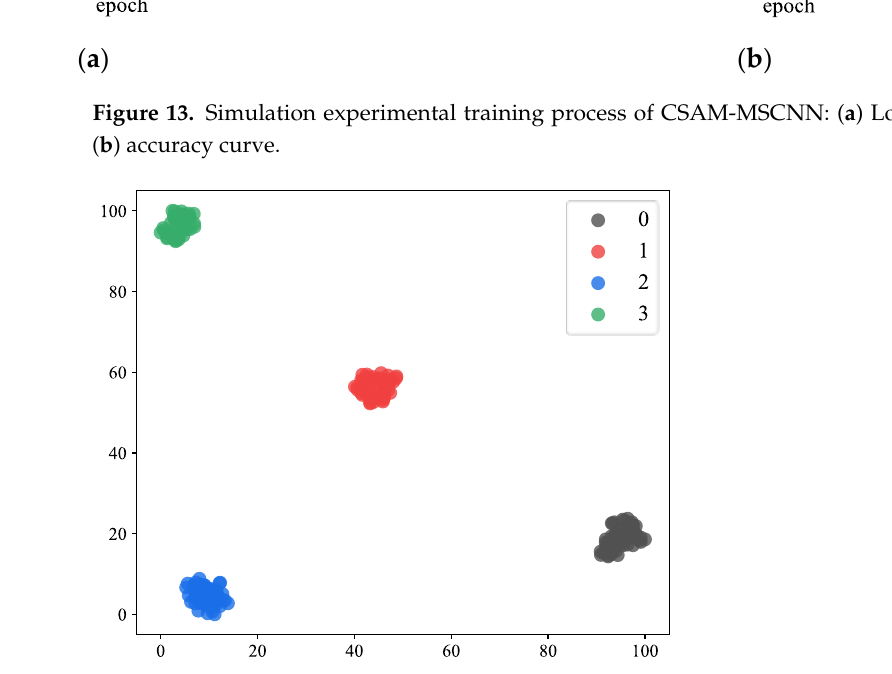
Table 7. Parallel experimental results of simulation data for CSAM-MSCNN.